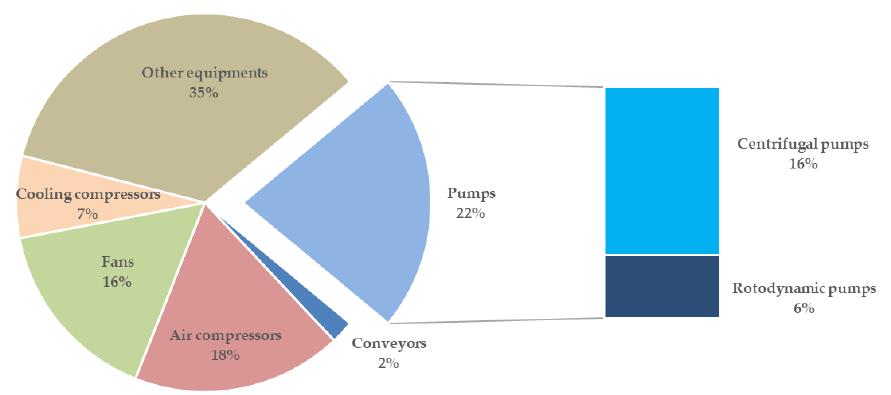
Figure 1. Energy consumption for different applications of electric motors.